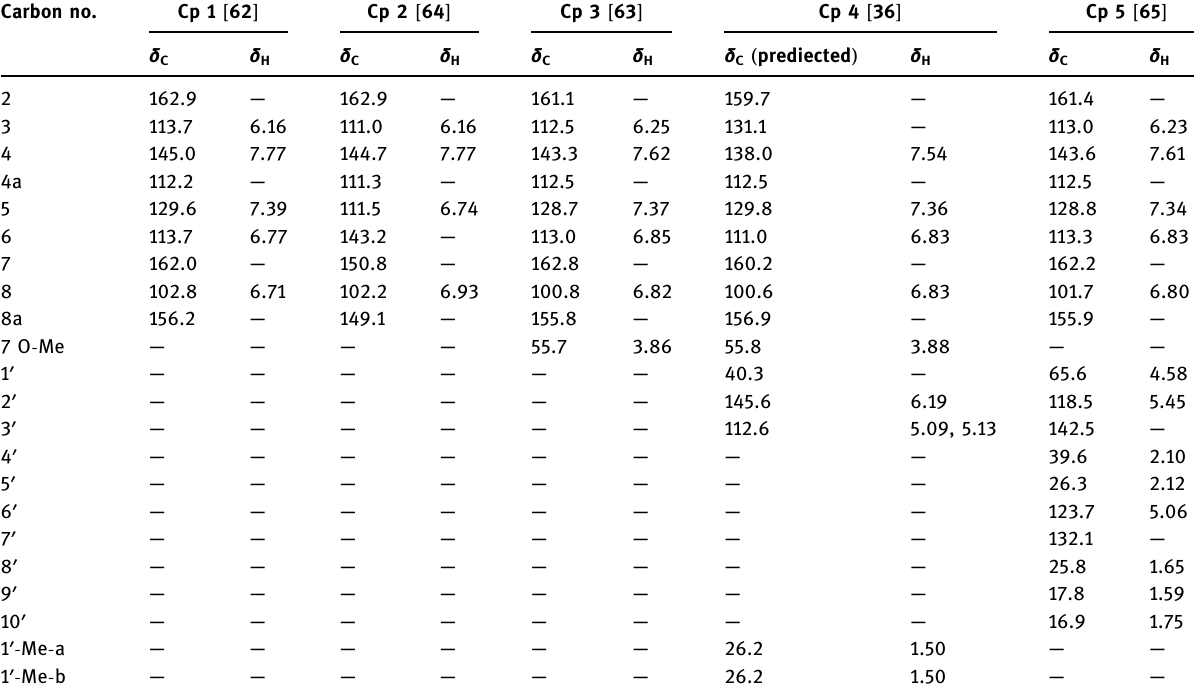
Table 2: 13 C and 1 H NMR ( δ , ppm ) chemical shift data of simple coumarins isolated from genus Casimiroa Carbon